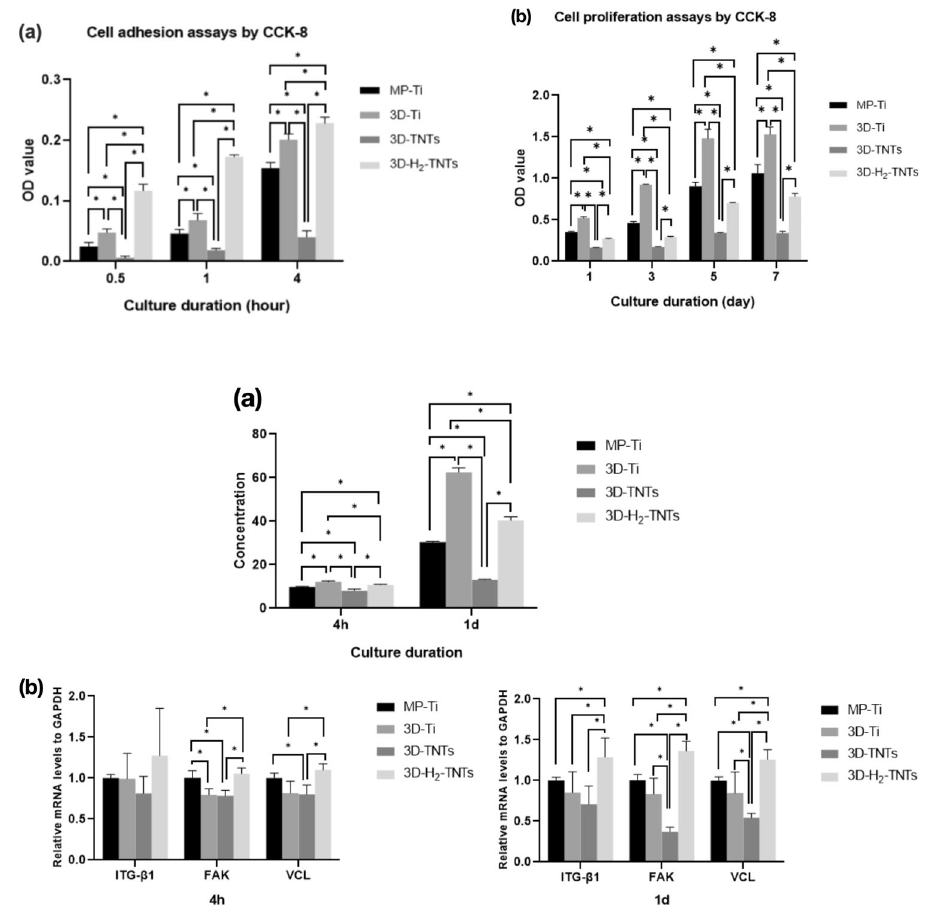
Fig. 5 Nuclei observation with DAPI fl uorescence staining. The HGFs were cultured on the MP-Ti, 3D-Ti, 3D-TNTs and 3D-H 2 -TNTs for 0.5 h, 1 h, and 4 h. The cells were labelled for nuclei